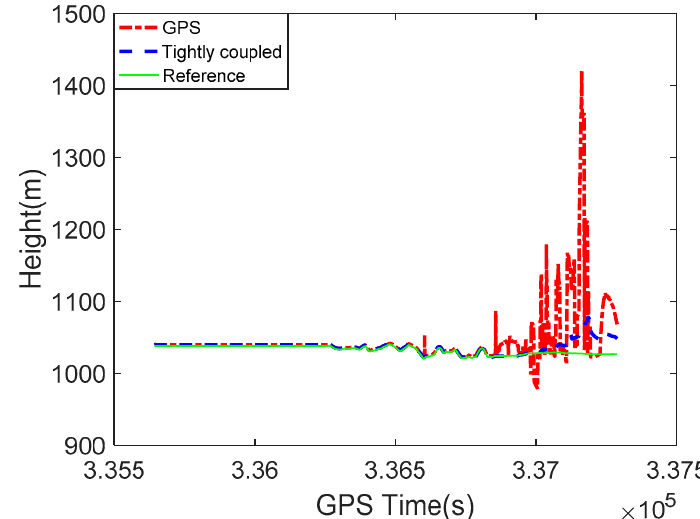
Figure 12. The height of the three results.